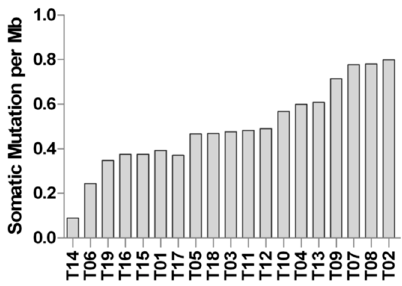
Figure 2. Mutational burden of D842V mutant GIST. The histogram bars indicate the number of somatic mutations per magabases (Mb) of coding region.